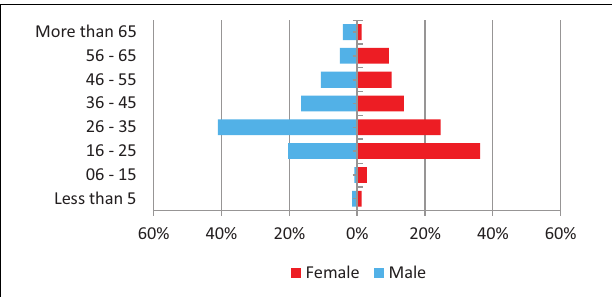
FIGURE 1 | Demographic of TB presumptive and follow-up